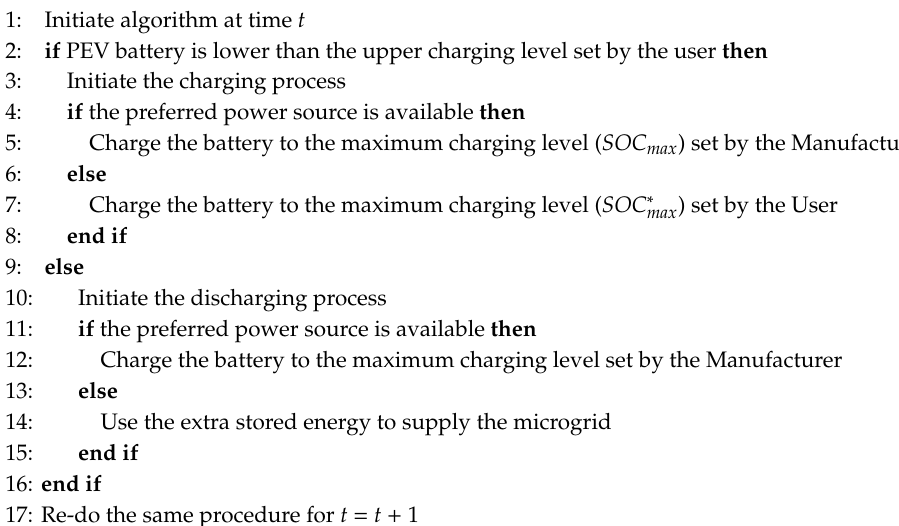
Algorithm 2: Optimization of the Charging and Discharging of a PEV